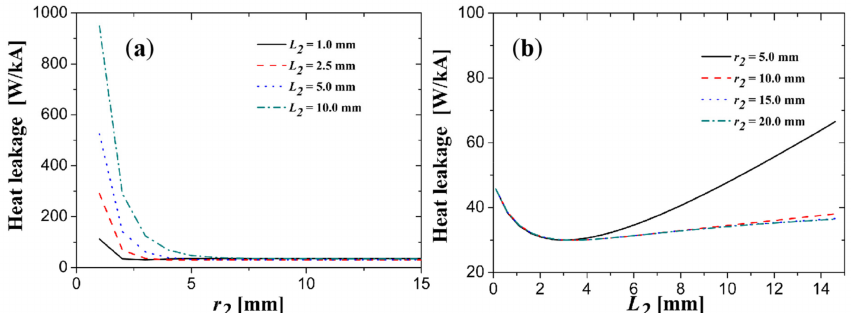
Figure A1. Iteration step 1: the coupling influence between D ( r 2 ) and E ( L 2 ) on the cold end heat leakage of PCLs (keeping parameters r 1 = 4.0 mm, L 1 = 10.0 mm, L 3 = 1500.0 mm unchanged; in this iteration Q min = 30.0 W/kA). ( a ) The heat leakage vary with D ( r 2 ); ( b )The heat leakage vary with E ( L 2